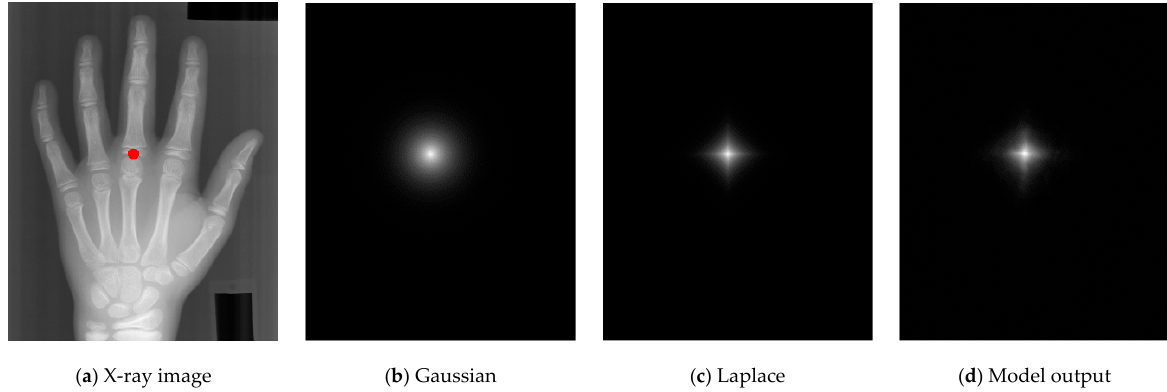
Figure 3. ( a ) is a visualization of landmarks of a resized sample image in the Digital Hand Atlas dataset. ( b – d ) are the heatmaps for a landmark of ( a ).